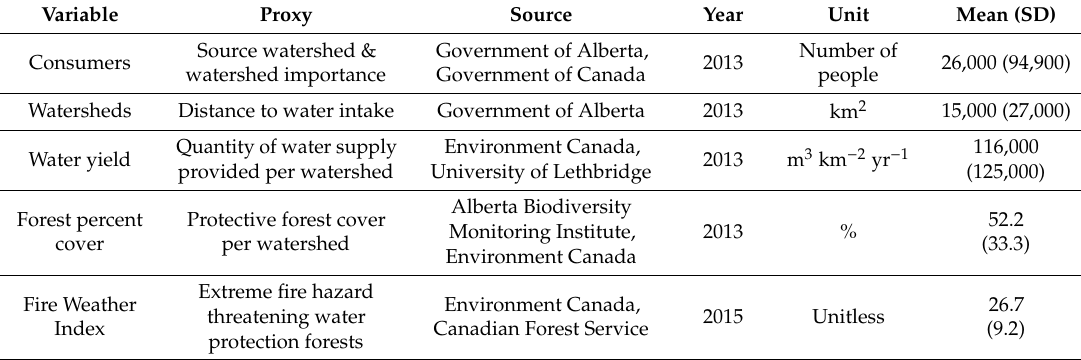
Table 1. Datasets used in the Source Exposure Index ( SEI ). Mean and Standard Deviation (SD) are for the raster grids extracted using the forested watersheds